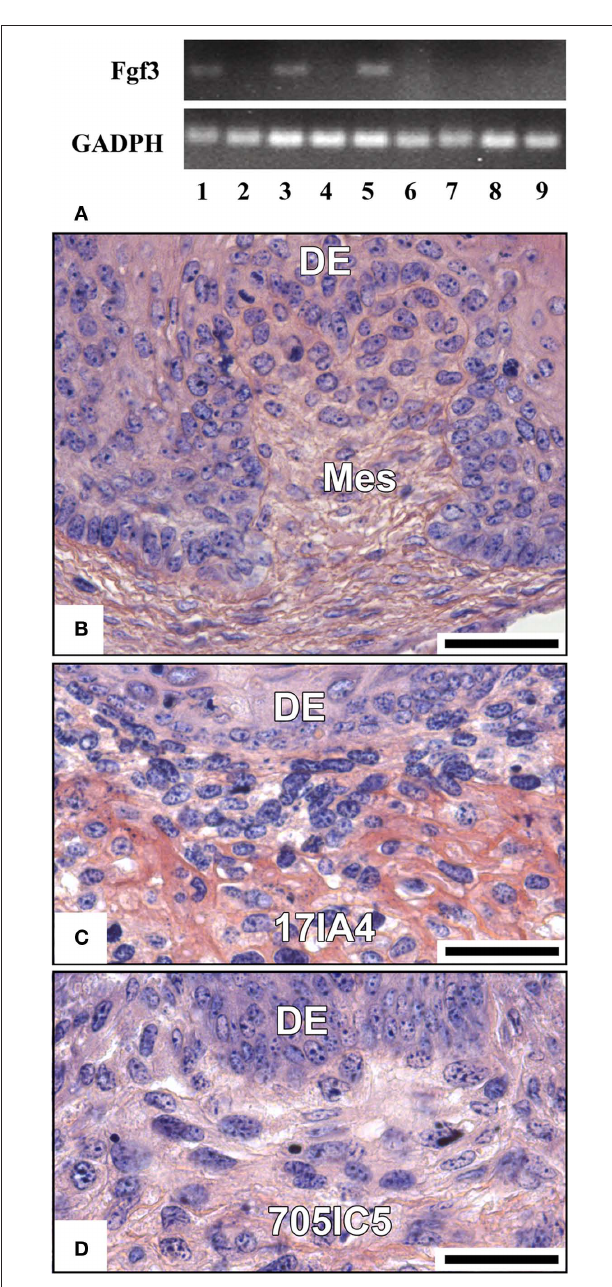
FiGuRe 6 | effect of FGF2 on the expression of Fgf3 (A) and cell potentialities in re-associations (B–D). FGF2 was added to the culture medium of ED14 dental mesenchymal cells or 17IA4 and 705IC5 cells for 1–4 days and its potential effect on Fgf3 was tested by RT-PCR. RT-PCR analysis of the expression of Fgf3 gene in dental mesenchymal cells from ED14 just after dissociation (lane 1), cultured for 1 day (lane 2) or 4 days (lane 4) without FGF2 or cultured in the presence of FGF2 for 1 day (lane 3), or 4 days (lane 5). 17IA4 and 705IC5 dental pulpal clones were also cultured either in the presence of FGF2 for 4 days (lanes 7 and 9 respectively) or without FGF2 (lanes 6 and 8 respectively). GADPH was used as an internal control. Dental mesenchymal cells from ED14 (B) , 17IA4 cells (C) , and 705IC5 cells (D) were cultured for 4 days in the presence of FGF2 and then for 10 days in re-association with an intact ED14 dental epithelium. DE, dental epithelium; Mes, mesenchyme. Bars = 40